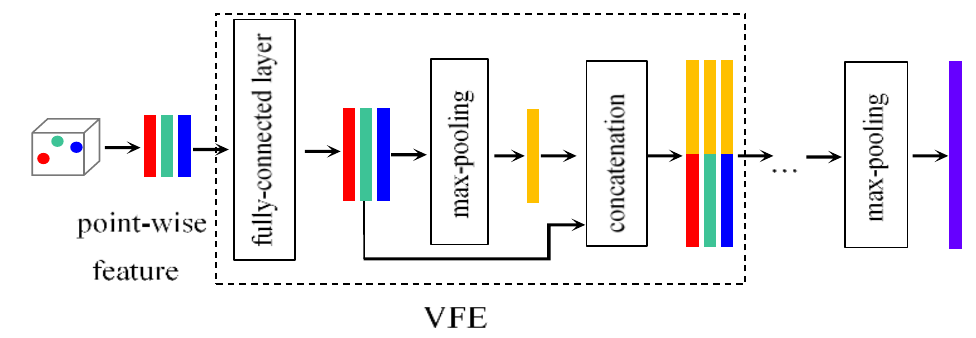
Figure 2. Structure of voxel feature extraction